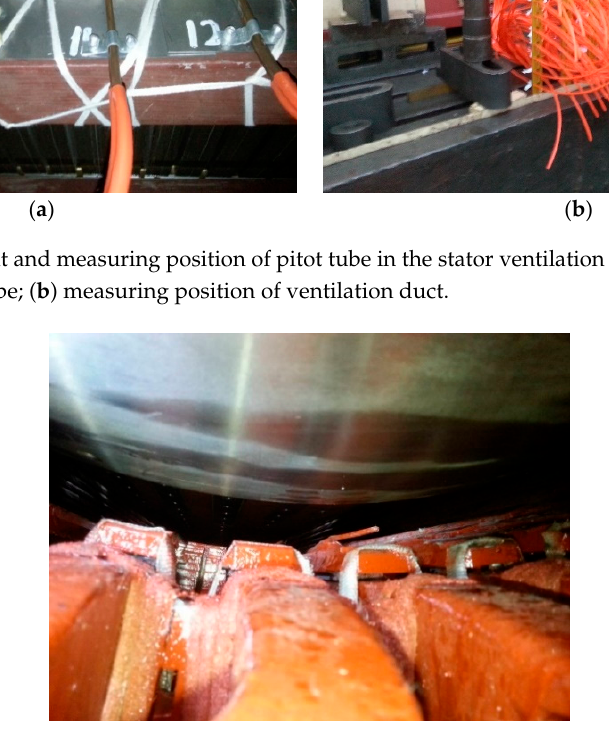
Figure 3. The sensor placement at the air gap entrance.